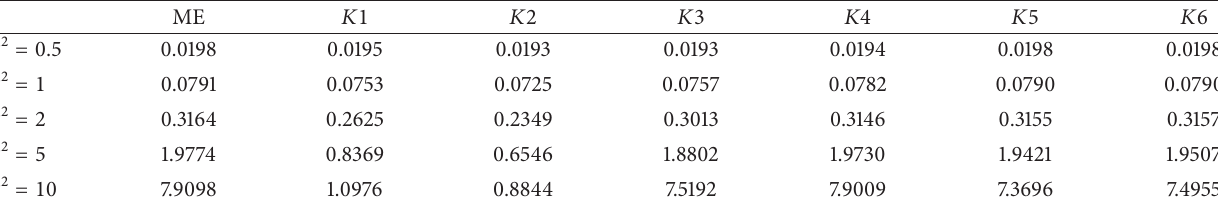
Table 3: Estimated MSE with 𝑛 = 50 , 𝑝 = 4 , and 𝛾 = 0.95 .